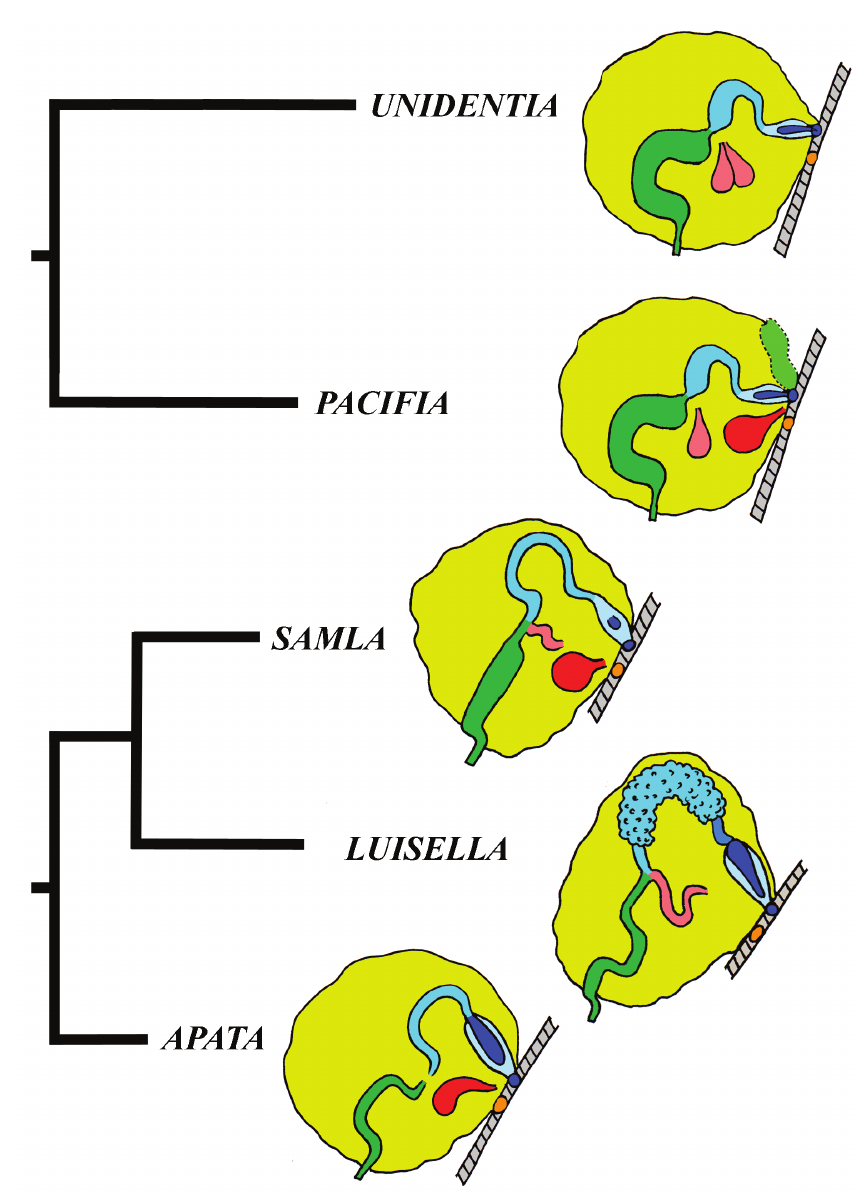
Figure 45. Schematic outline of the reproductive systems of the taxa of the families Unidentiidae, Sam- lidae fam. n. and Apataidae fam. n. integrated with molecular phylogenetic data. Colour indication of reproductive system characters: ampulla – green; body wall – gray; distal receptaculum seminis – red; female gland mass – yellow; female genital opening – orange; penis and male genital opening – dark blue; penial sheath – pale blue; prostate and prostatic vas deferens – turquoise; proximal receptaculum seminis – pink; supplementary gland – light